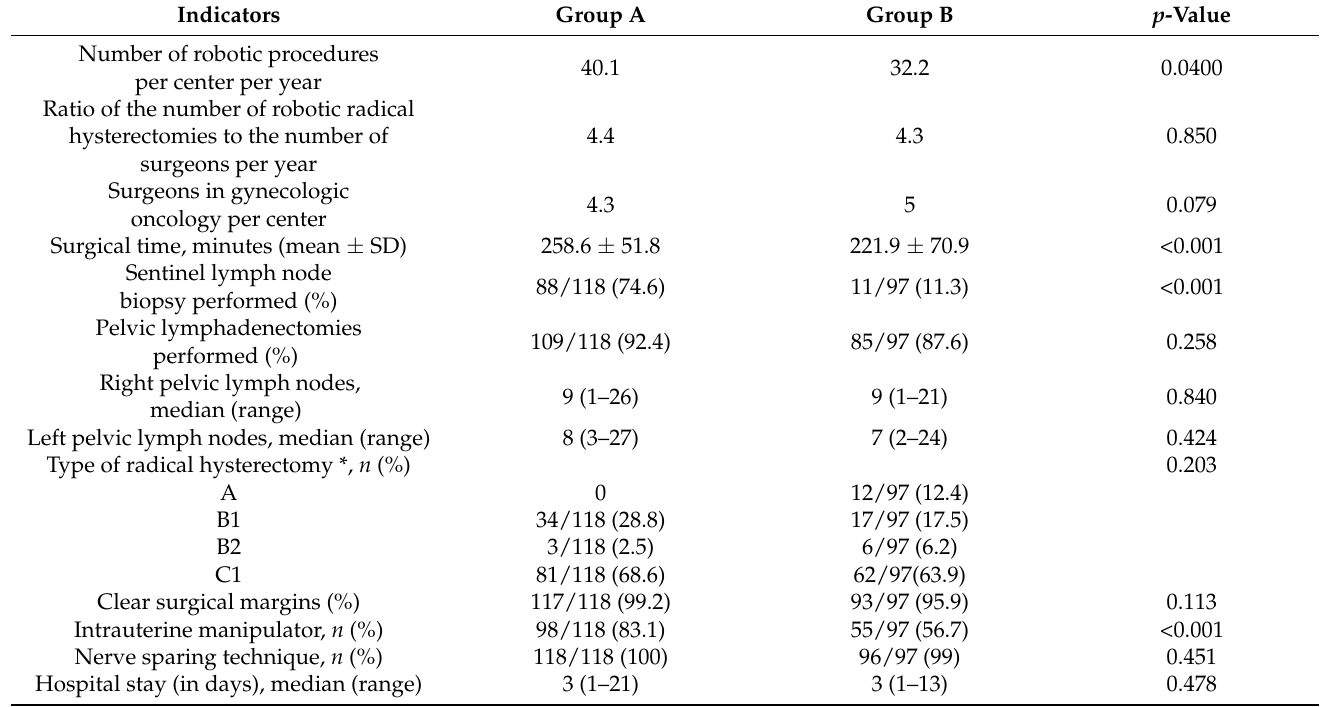
Table 4. Surgical activity and surgical techniques.